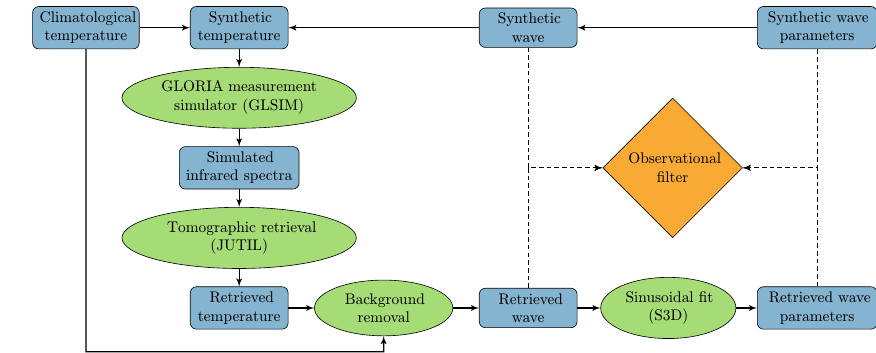
Figure 1. Methodological concept of the performed simulation study. A detailed description can be found in Sect. 2.1.